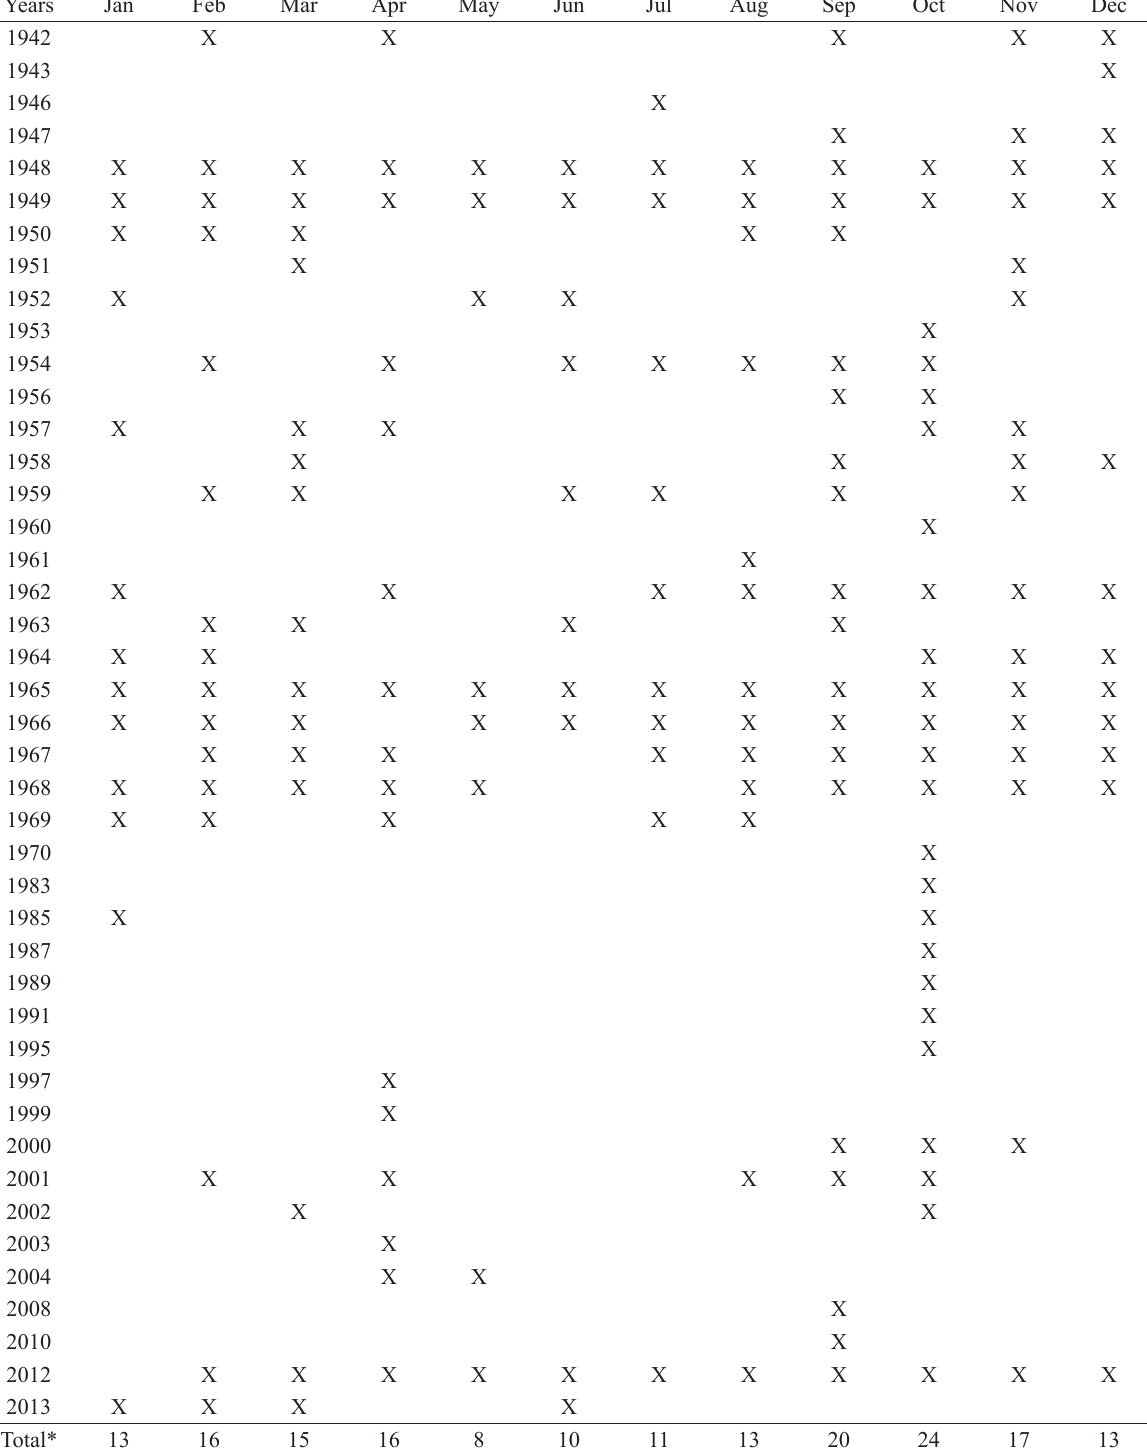
Months and years with records of Saturniidae (Lepidoptera) from the Boraceia Biological Station, São Paulo, Brazil.